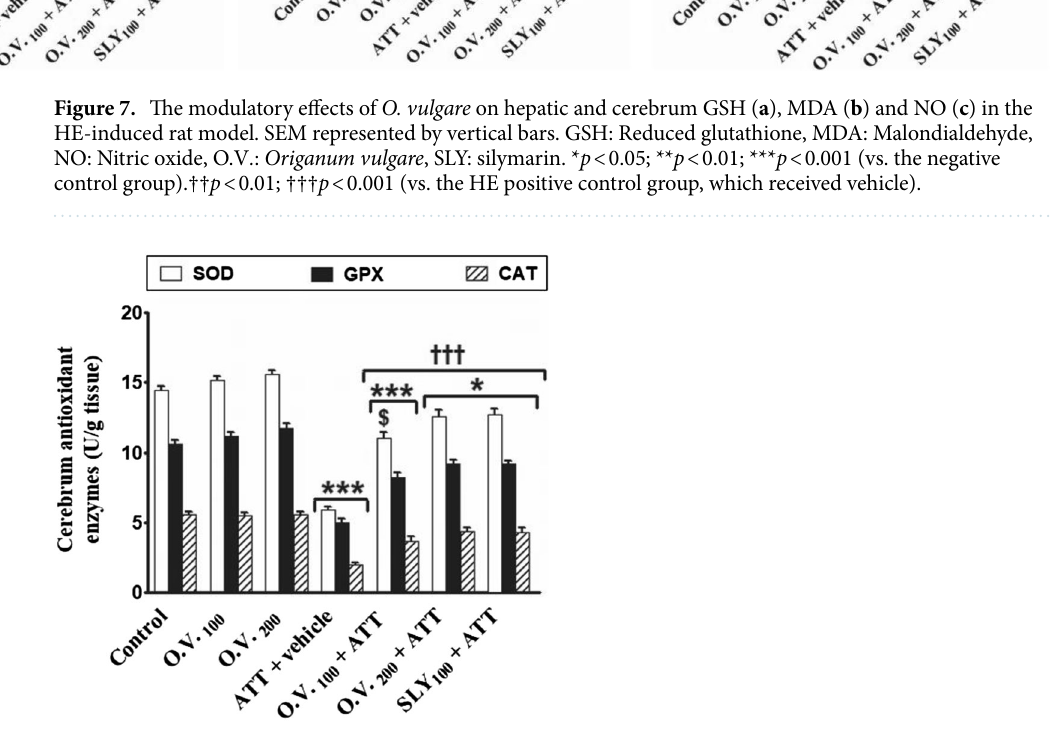
Figure 8. The modulatory effects of O. vulgare on cerebrum antioxidant enzymes in the HE-induced rat model. SEM represented by vertical bars. CAT: catalase, GPX: glutathione peroxidase, O.V . : Origanum vulgare , SLY: silymarin, SOD: superoxide dismutase. * p < 0.05; *** p < 0.001 (vs. the negative control group). ††† p < 0.001 (vs. the HE positive control group, which received vehicle). $ p < 0.05 (vs. the HE group, which received